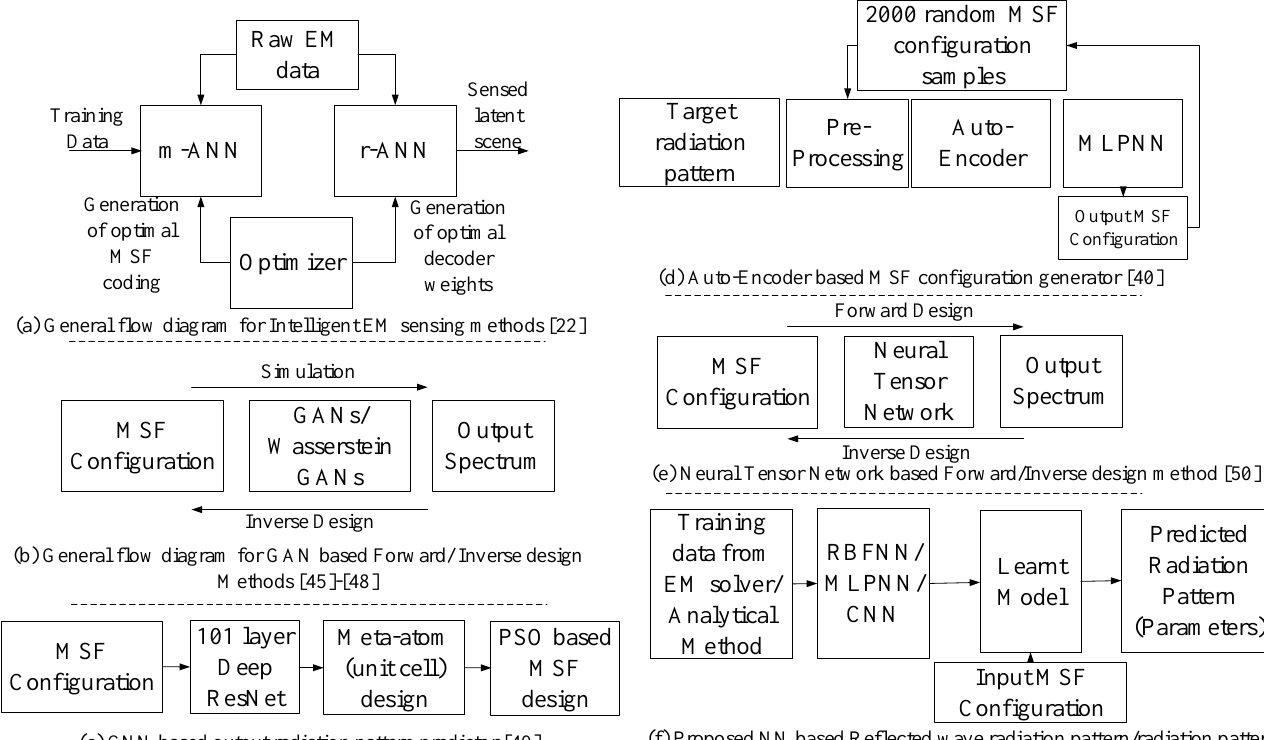
Figure 2. Schematic representation of state of the art approaches and the proposed